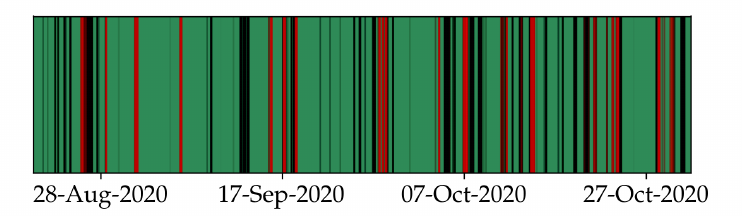
Figure 7. Distribution of valid forecast times throughout the assessment period (green lines; 84.19%). The black lines depict periods when less than five valid LiDAR scans could be retrieved within five minutes before forecast (11.31%). The red lines represent periods of abnormal wind farm operation (outages and negative or curtailed generation;